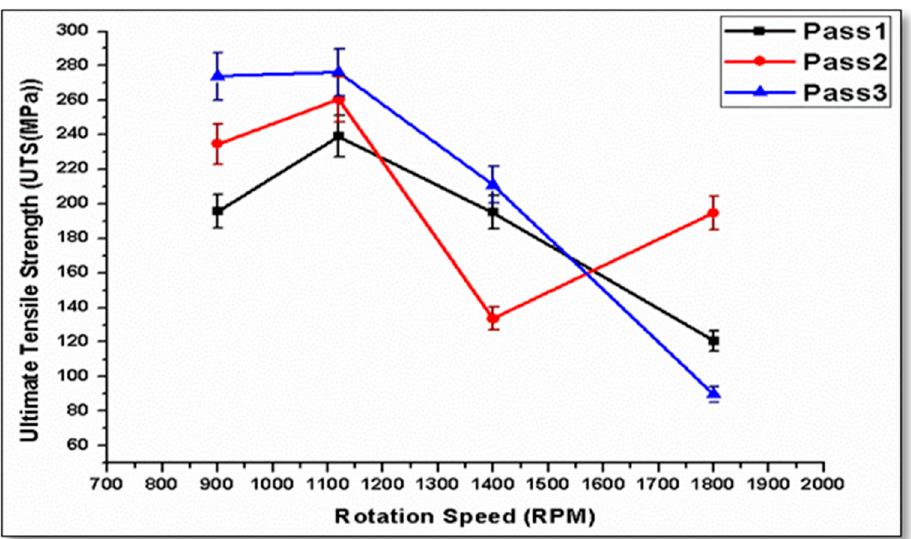
Figure 6. Effect of rotational speed on the ultimate tensile strength at a 10 mm/min travel speed for the three passes. UTS: ultimate tensile strength.